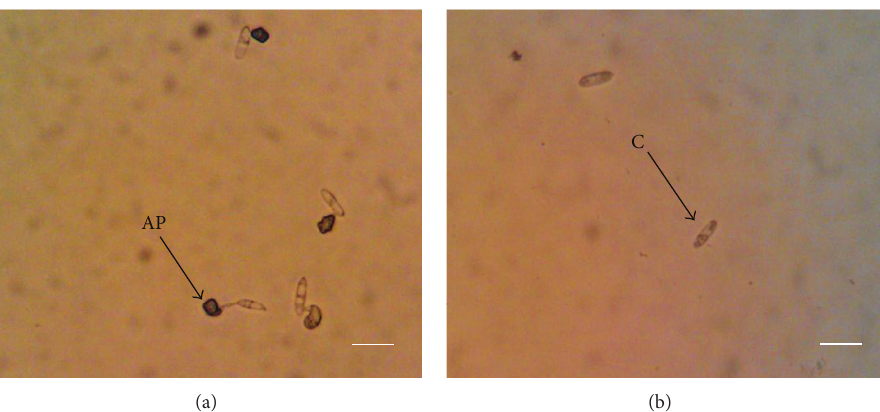
Figure 2: Effect of methyl gallate on inhibition of conidial germination of Colletotrichum higginsianum PA-19. (a) An irregular brown appressorium (AP) formed after conidial germination in distilled water (check); and (b) conidium (C) failed to germinate in the solution with 22.1 𝜇 g/mL of methyl gallate (bar scale = 20 𝜇 m).